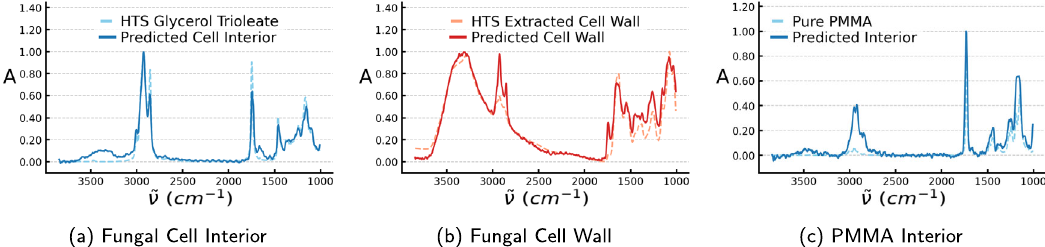
Fig. 4 Predictions of spatially resolved absorbance compared with pure spectra. a The model ’ s median prediction of molecular absorption in the interior of the cell and HTS-FTIR measurement of the glyceryl trioleate which is known to be produced by Mucor circinelloides 24 . b Median prediction of cell wall absorption and measured HTS-FTIR spectra of the cell wall of Mucor circinelloides fungal cells obtained from sonication and extraction to remove the fatty acids from the total biomass. c The median prediction of the interior absorption of PMMA spheres and pure, scatter-free measured absorption spectrum of a PMMA